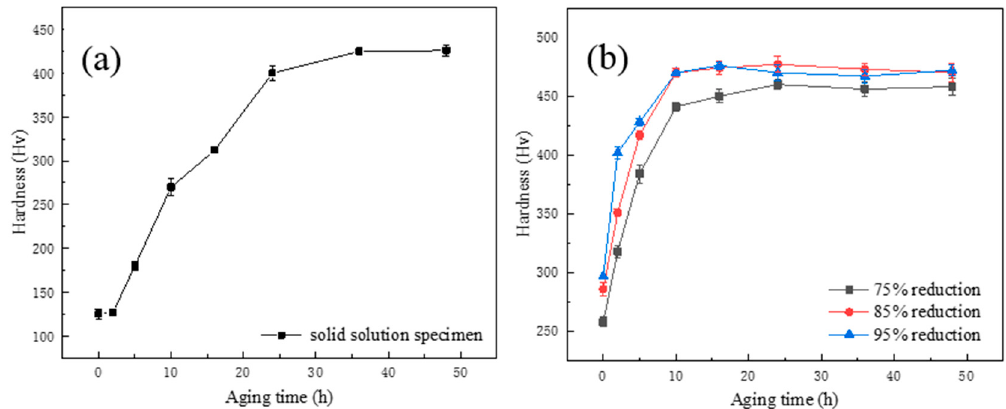
Figure 2. Variation of hardness of the specimens during aging process, ( a ) the variation of hardness of solid solution specimen, ( b ) the variation of hardness of specimen treated with different reduction.